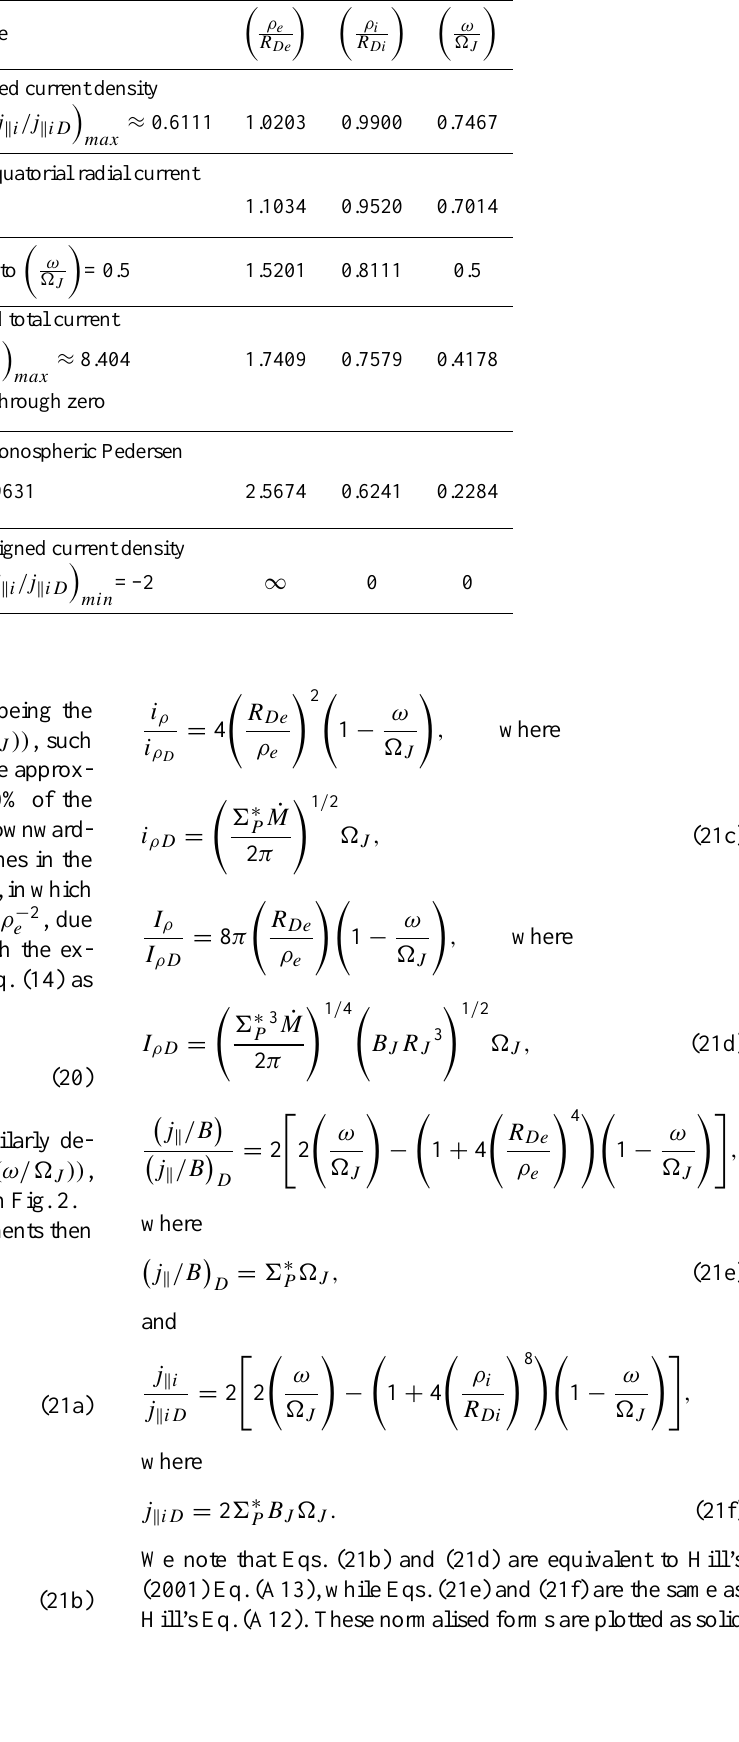
Table 1. Principal features of the plasma angular velocity and coupling current system for a dipole field in normalised units